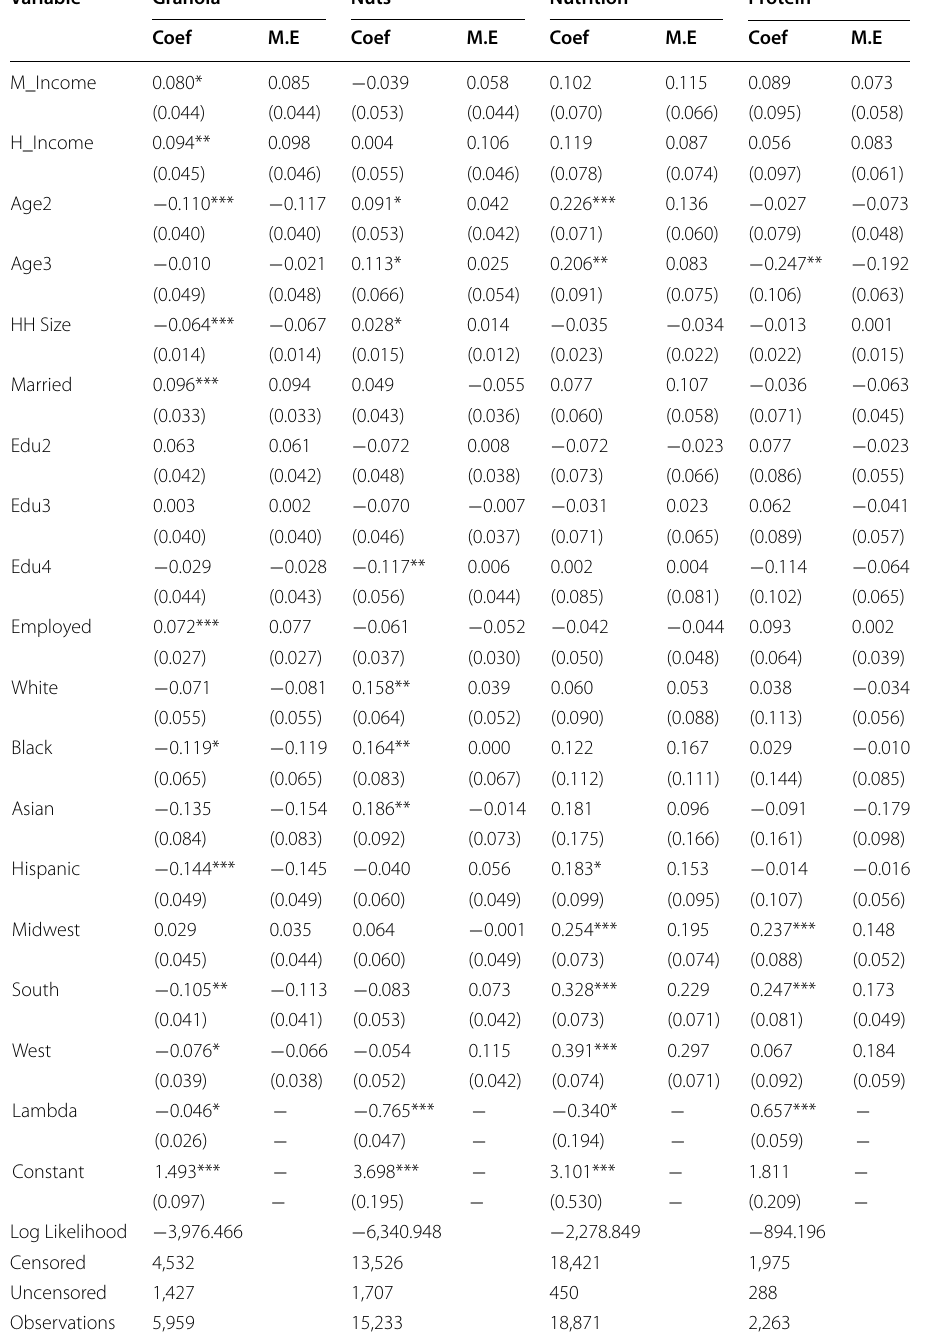
Table 6 Second stage estimation